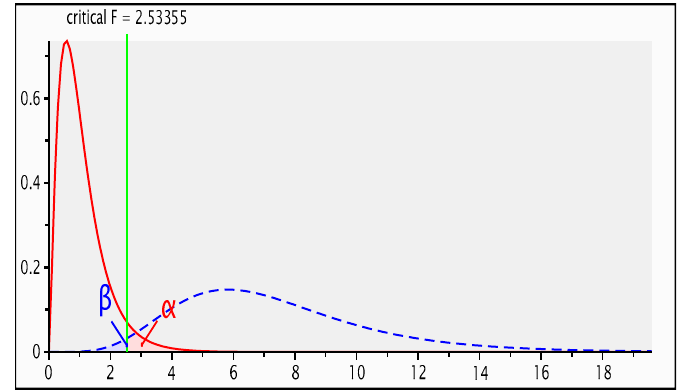
Figure 1. G-Power analysis for statistical power, effect and sample size.